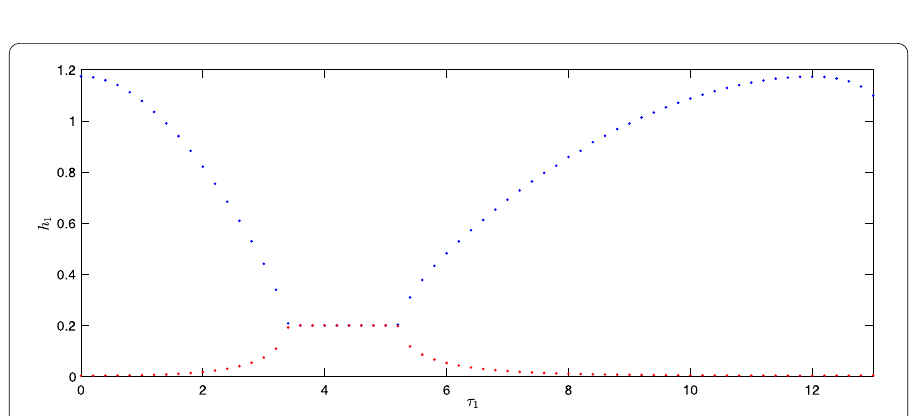
Figure 4 τ 1 -bifurcation diagram of system (2.2) under case d > A with parameter ε = 1, κ = 2, μ = 0.17, d = 0.1, m = 0